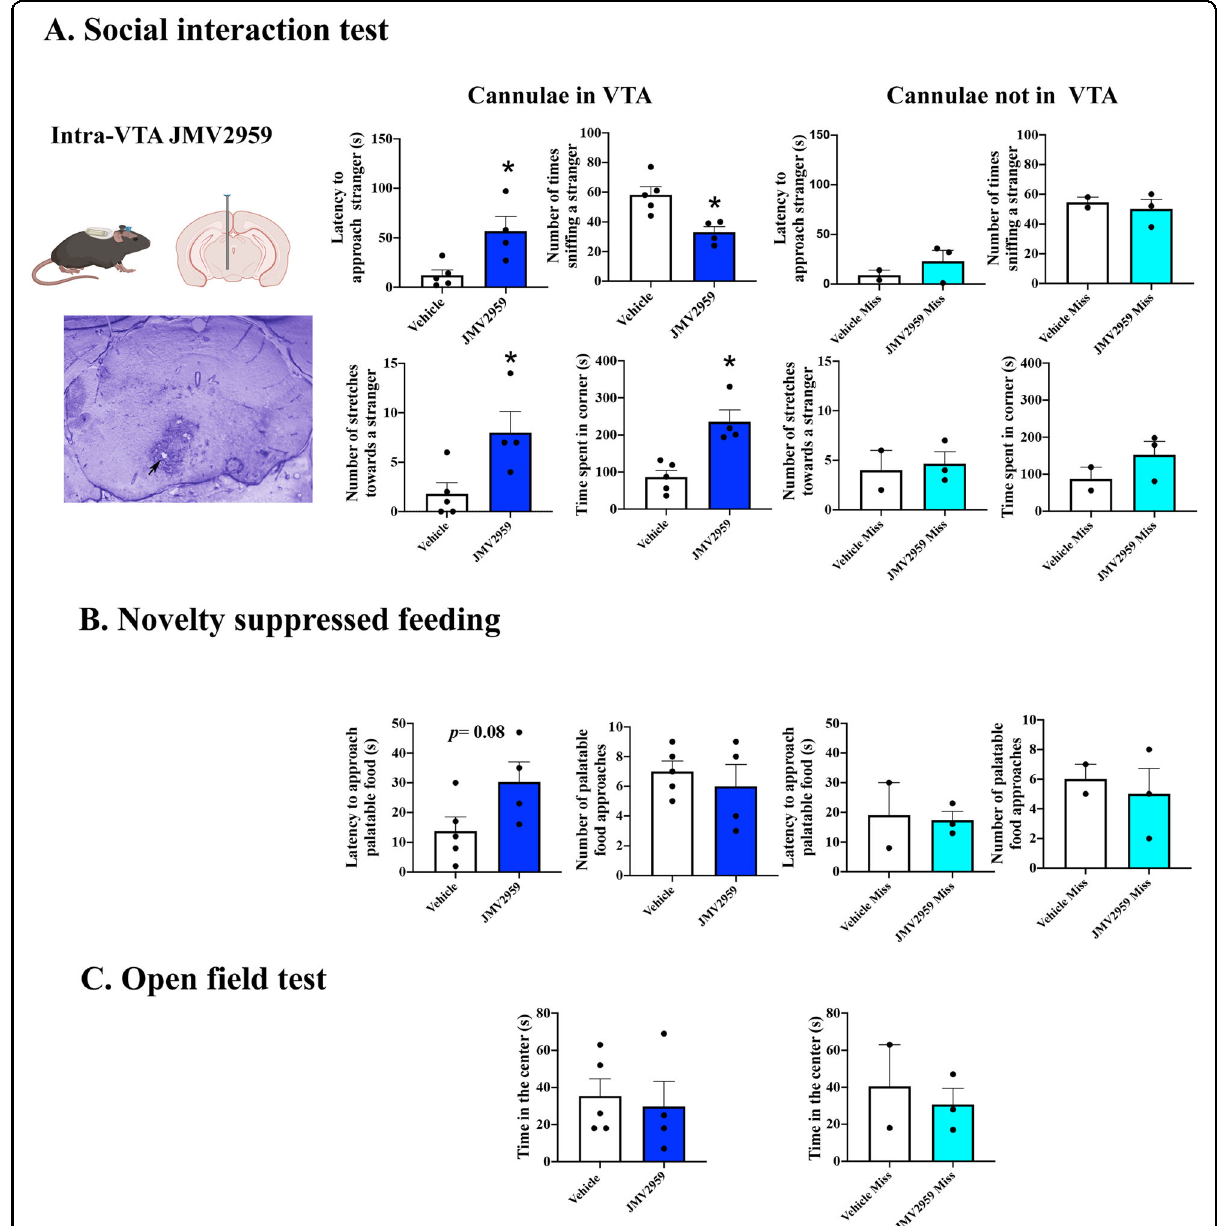
Fig. 3 Behavioral responses of mice receiving chronic unilateral intra-VTA infusions of the GHSR antagonist JMV2959 (6 μ g/day at a rate of 0.11 μ l/h)( n = 4 with cannula in the VTA) or saline ( n = 5). Intra-VTA treatment with JMV2959 decreased the latency to approach and the frequency of investigation of a stranger con-speci fi c (see Panel A ; p < 0.05). This treatment also resulted in increased vigilance as re fl ected in an increase in the number of stretches and in the amount of time spent observing the stranger from the corner of the testing arena (see Panel A ; p < 0.05). Intra VTA treatment with JMV2959 was not effective in increasing the latency to approach a palatable snack (see Panel B ). Finally, intra-VTA JMV2959 treatment did not affect behavior in the open fi eld test (see Panel C ). No signi fi cant differences between groups were observed in mice where the cannula placements were outside of the VTA. * p <